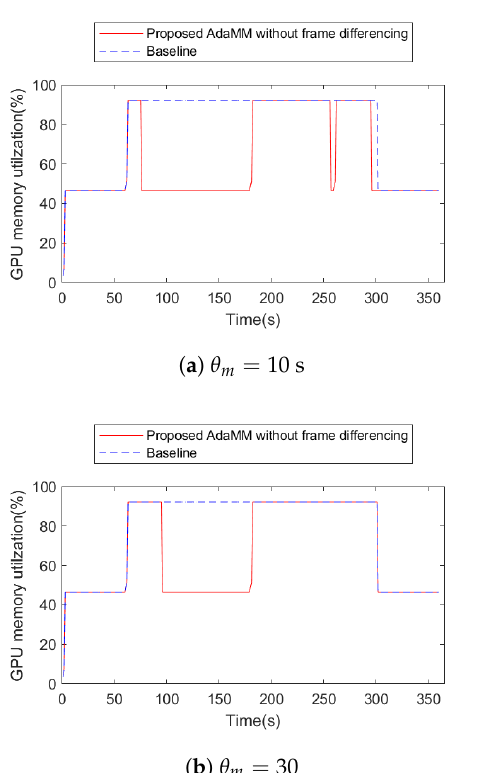
Figure 7. GPU memory utilization on 2nd edge server with proposed AdaMM framework compared to Baseline